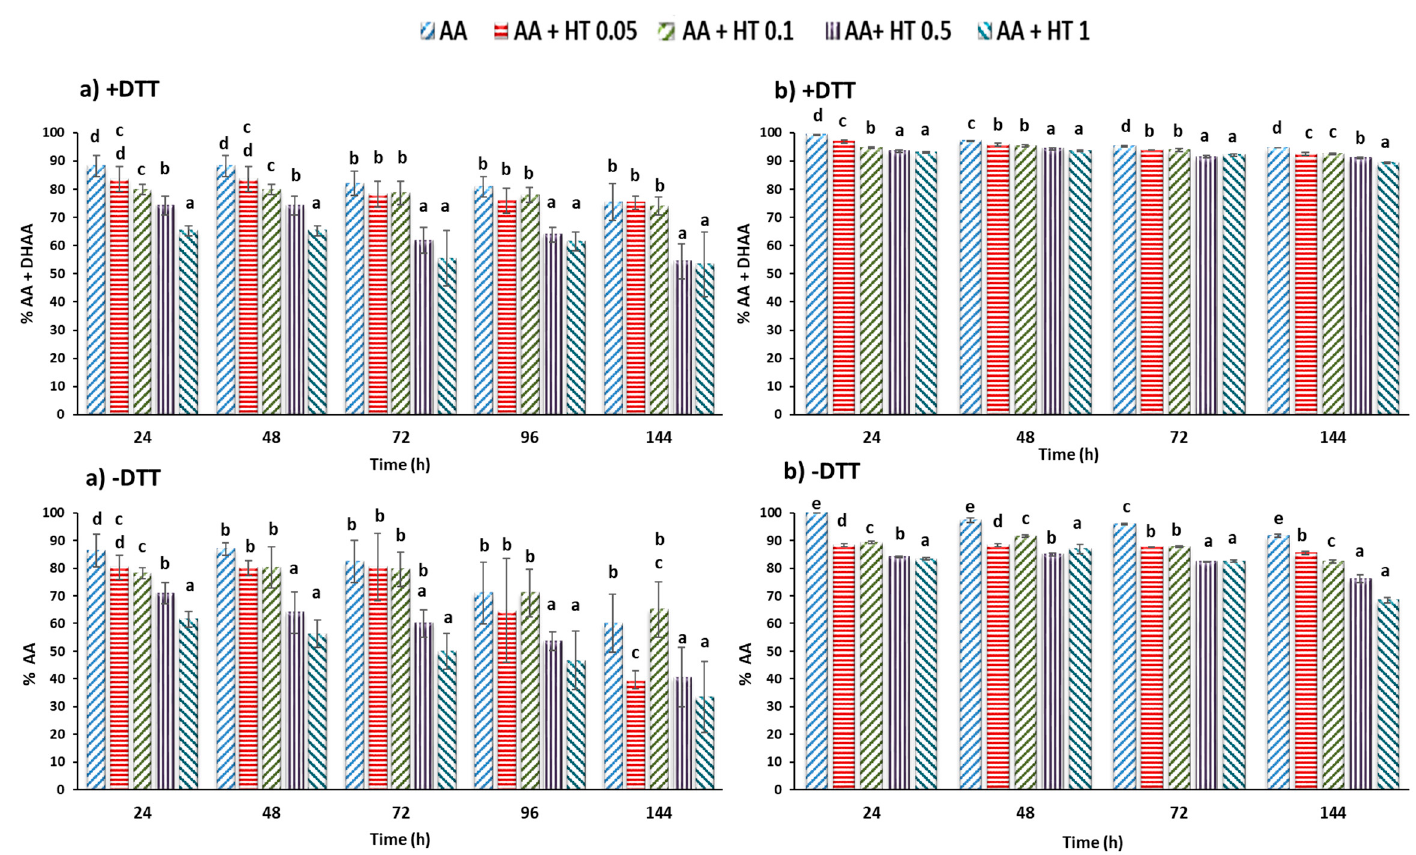
Figure 1. The evolution of the vitamin C content of a model system solution (0.6 mg/mL) with different concentrations of HT added (0.05, 0.1, 0.5 and 1 mg/mL of solution) stored at room temperature ( a ) and at 4 °C ( b ) with DTT (+DTT = total ascorbic [AA+DHAA]) and without DTT ( − DTT only acid ascorbic, AA). The data are shown as mean ± SD of quadruplicates. Letters (a–e) indicate significant differences among groups at p < 0.05.